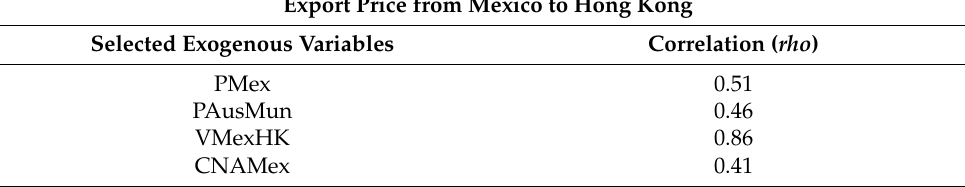
Table 2. Correlation between the export price of Mexican lobster to China (dependent variable) and the selected exogenous